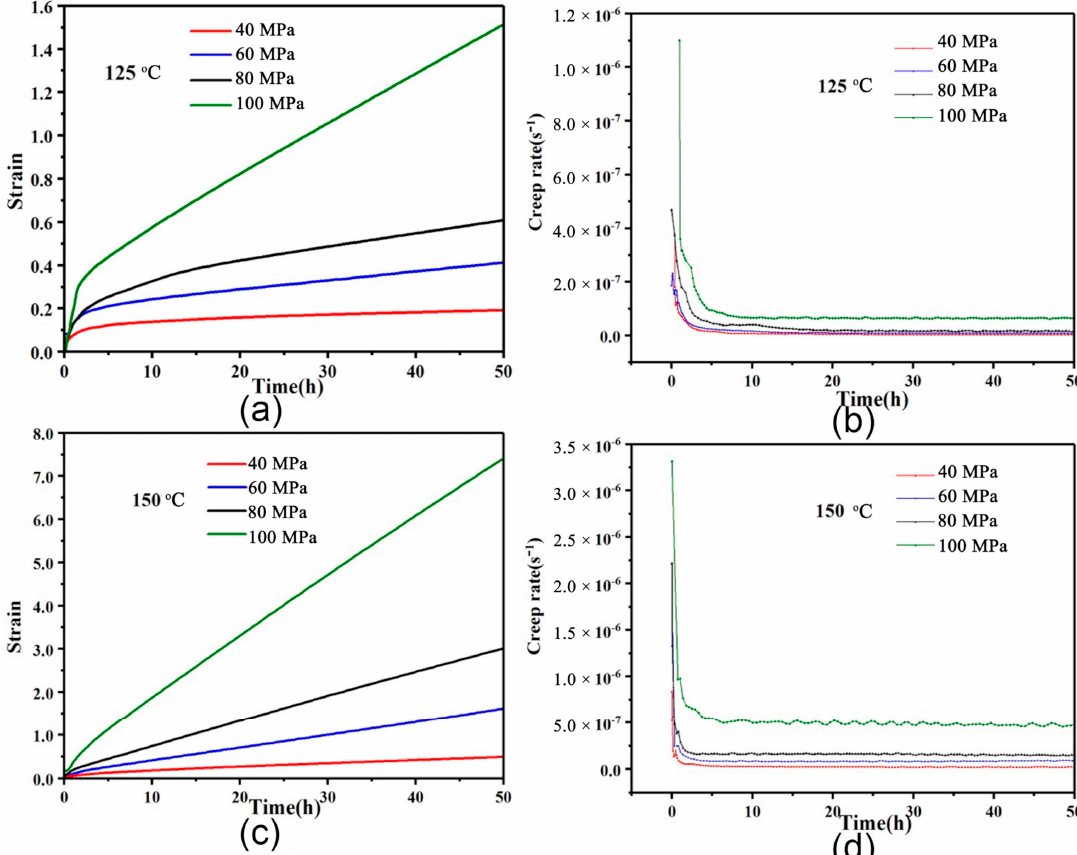
Figure 7. Creep curves and corresponding creep rate-time curves of the as-extruded AZXSE91000 alloy at 125–150 ◦ C, 40–100